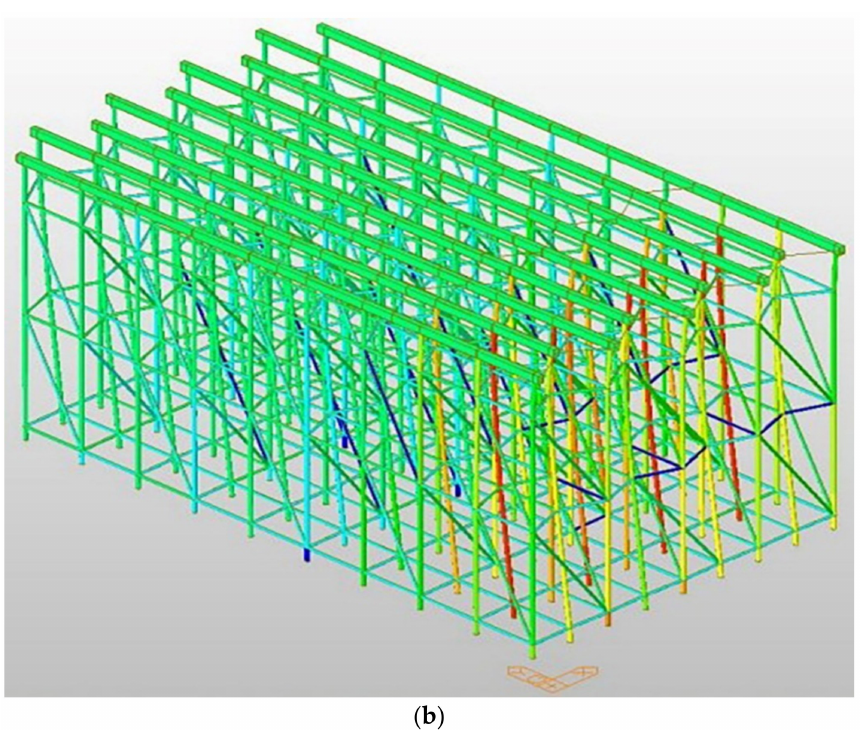
Figure 22. Distributed pour and concentrated pour 3D modeling review. ( a ) Distributed pour-stress state; ( b ) pour-stress state.